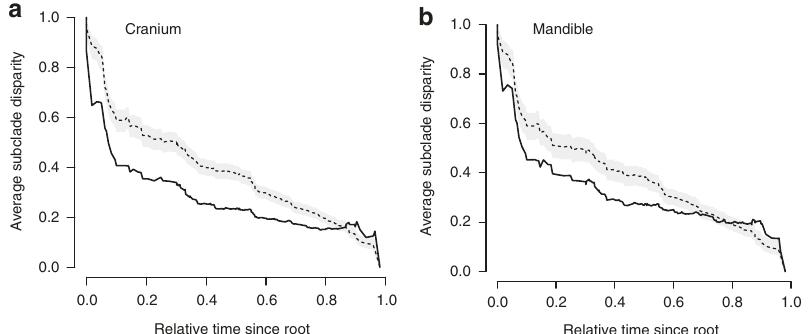
Fig. 2 Disparity-through-time plots for the shape of the cranium and mandible across bats. Thick black line = observed subclade disparity. Gray polygon = area of 95% con fi dence interval of BM simulated character histories. Dashed line = medium DTT curve of BM simulated character histories. See